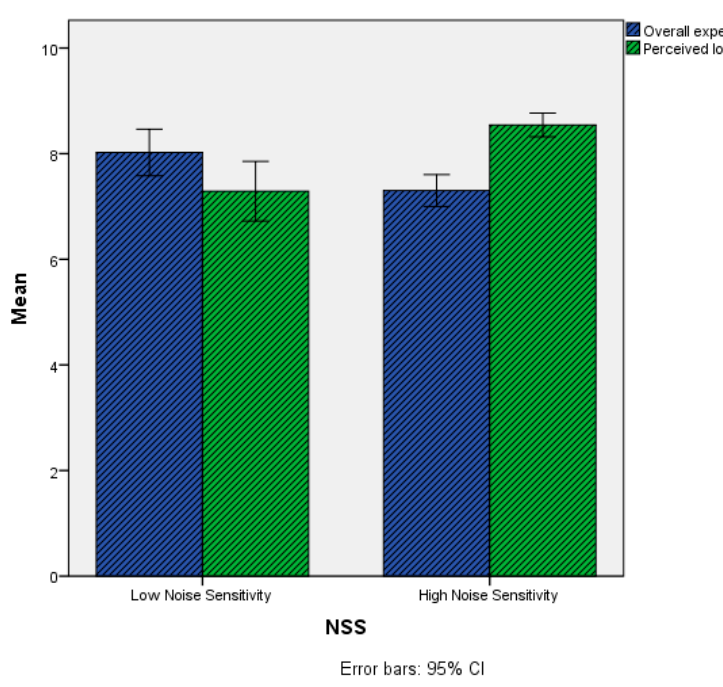
Figure 6. Mean scores of the Perceived loudness and Overall experience items as a function of the NSS variable. Grey-shaded bars refer to items where statistically significant differences were observed between the two groups.